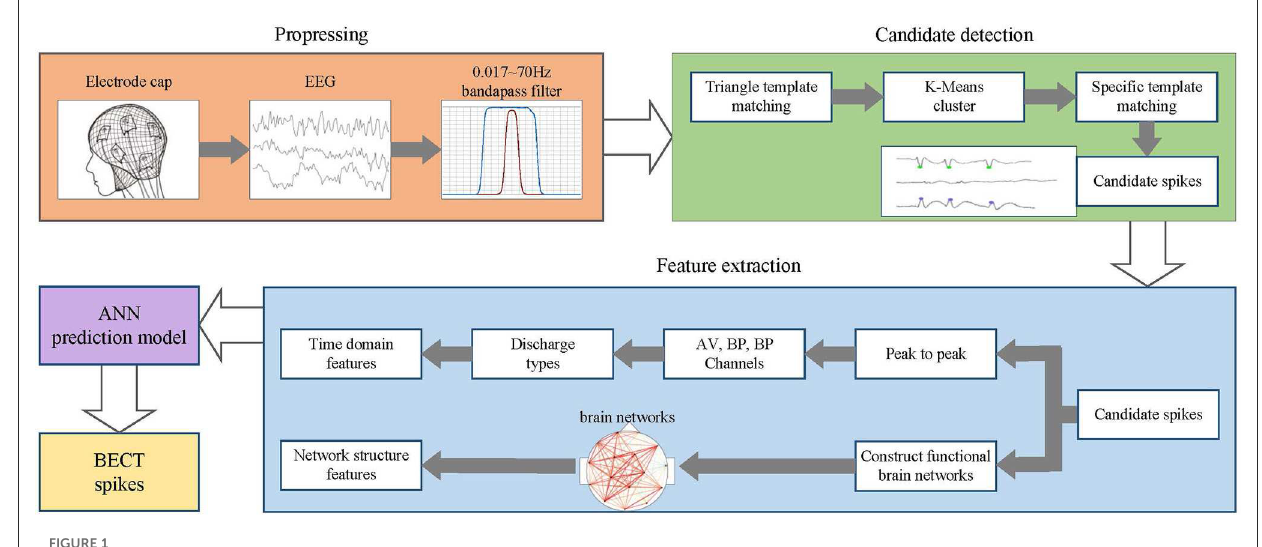
FIGURE1 Flowchart of BECT spike detection algorithm based on